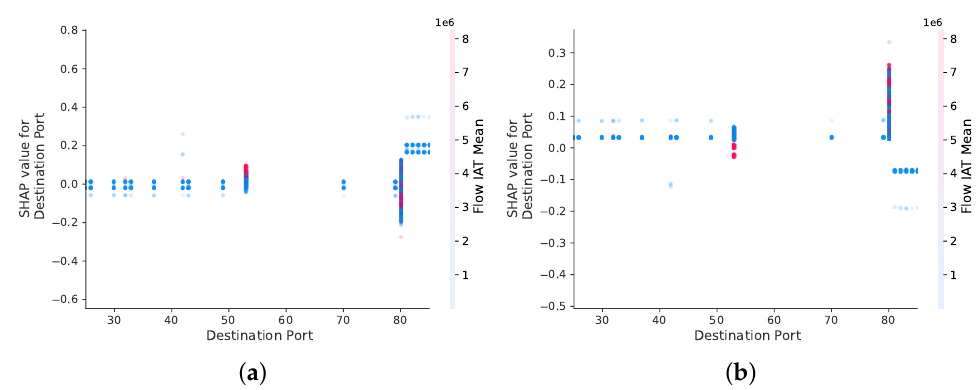
Figure 10. Flow IAT Mean/Destination Port interaction plots. ( a ) Flow IAT Mean/Destination Port interaction for benign traffic; ( b ) Flow IAT Mean/Destination Port interaction for DoS attacks.